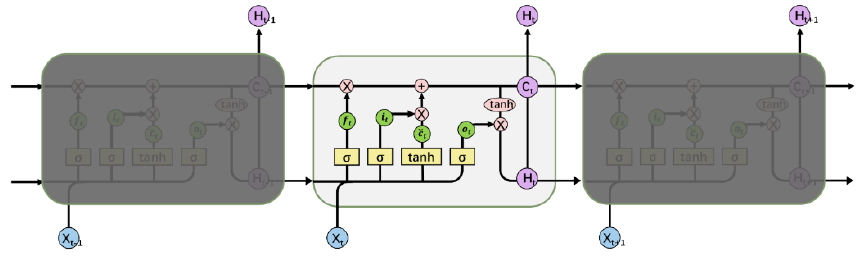
Figure 3. Cyclic cell structure of the LSTM network.